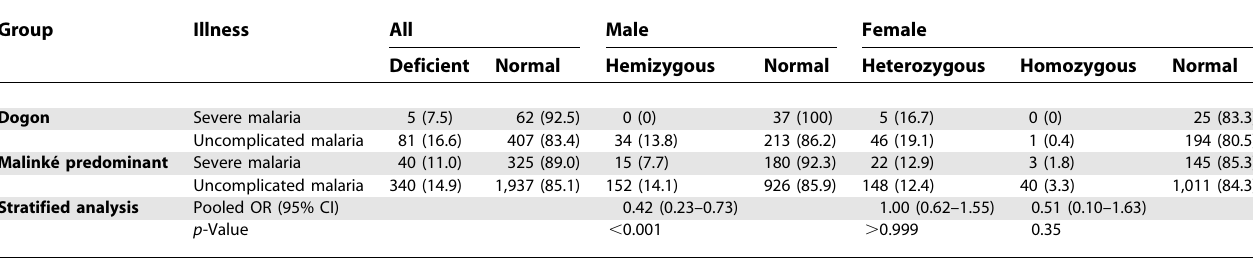
Table 1. Distribution of Severe and Uncomplicated Malaria in Recruited Children According to Ethnicity, Sex, and G6PD Genotype Group Illness All Male Female